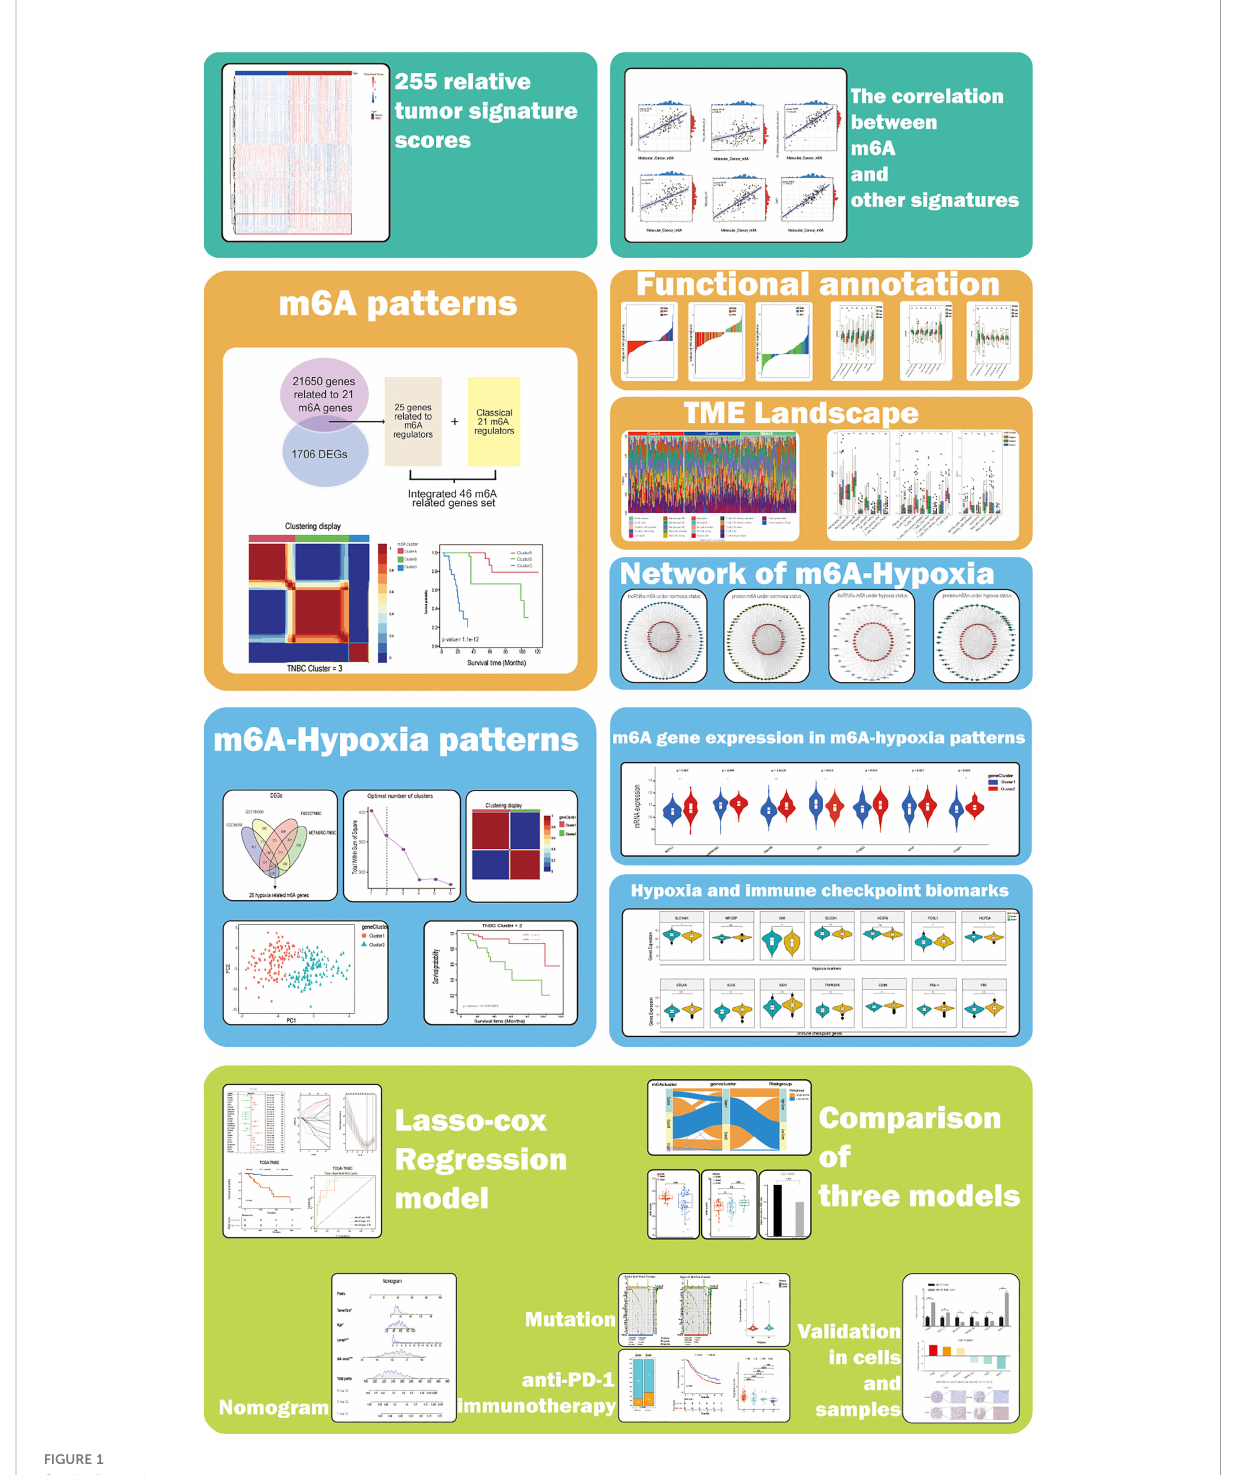
FIGURE 1 Study fl ow